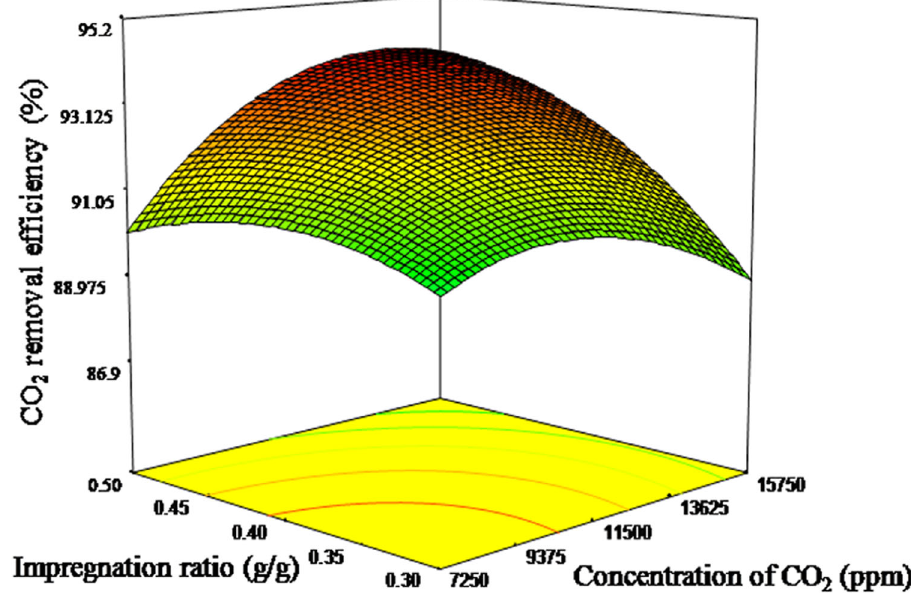
Fig. 11 The 3D plot showing the optimum region for the combined effect of inlet concentration of CO 2 and impregnation ratio for the CO 2 removal efficiency